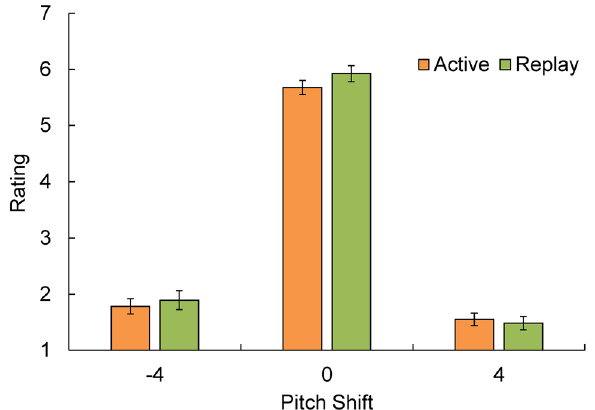
Figure 3. Rating score in each voice condition of the active and replay sessions. Error bars represent standard